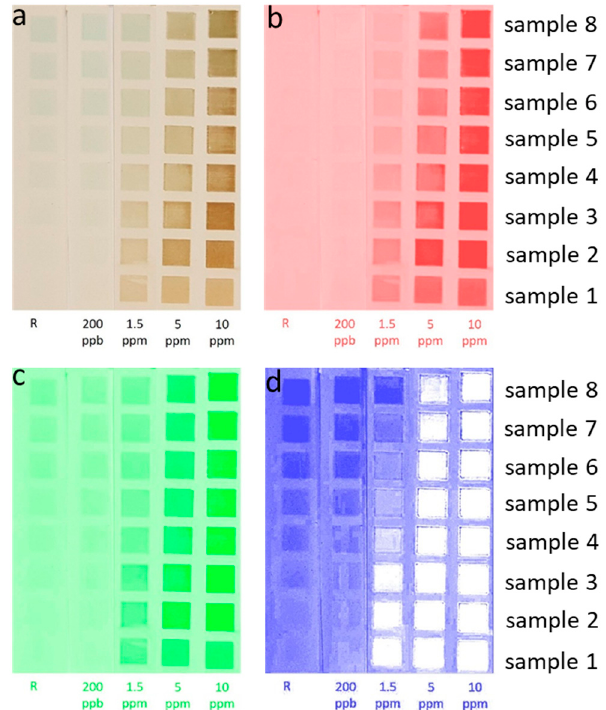
Figure 7. ( a ) A picture of the developed colorimetric paper strip for the detection of H 2 S before and after exposure to di ff erent concentrations of H 2 S; The RGB color deconvolution of the picture using open source image analysis software to ( b ) the red channel; ( c ) the green channel and ( d ) the blue channel. For visualization contrast, saturated pixels are enhanced by